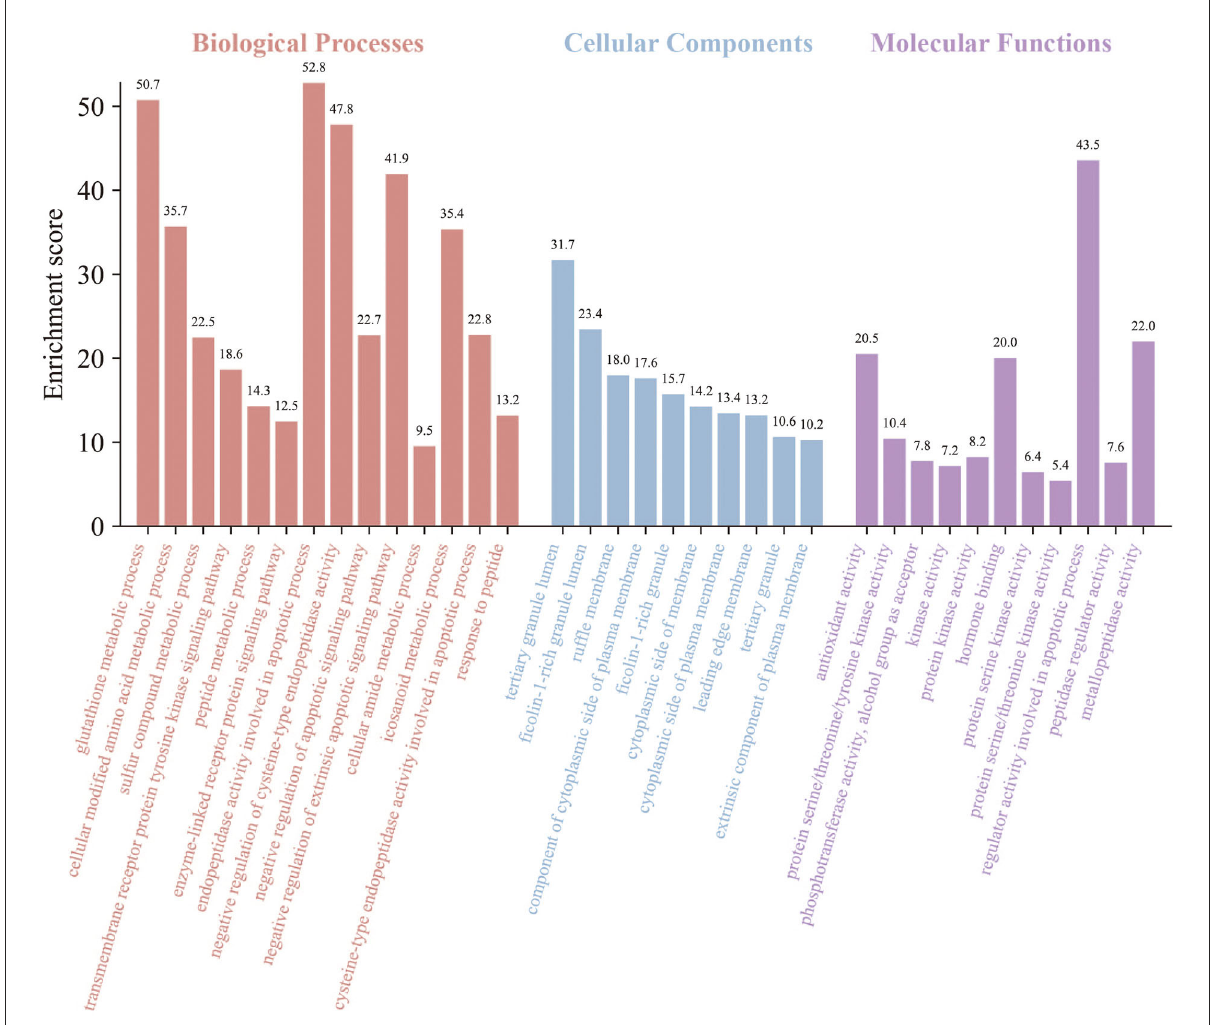
FIGURE4 Gene ontology (GO) enrichment of key targets. Biological processes, cellular components, and molecular functions were mentioned. The enrichment scores were marked in the